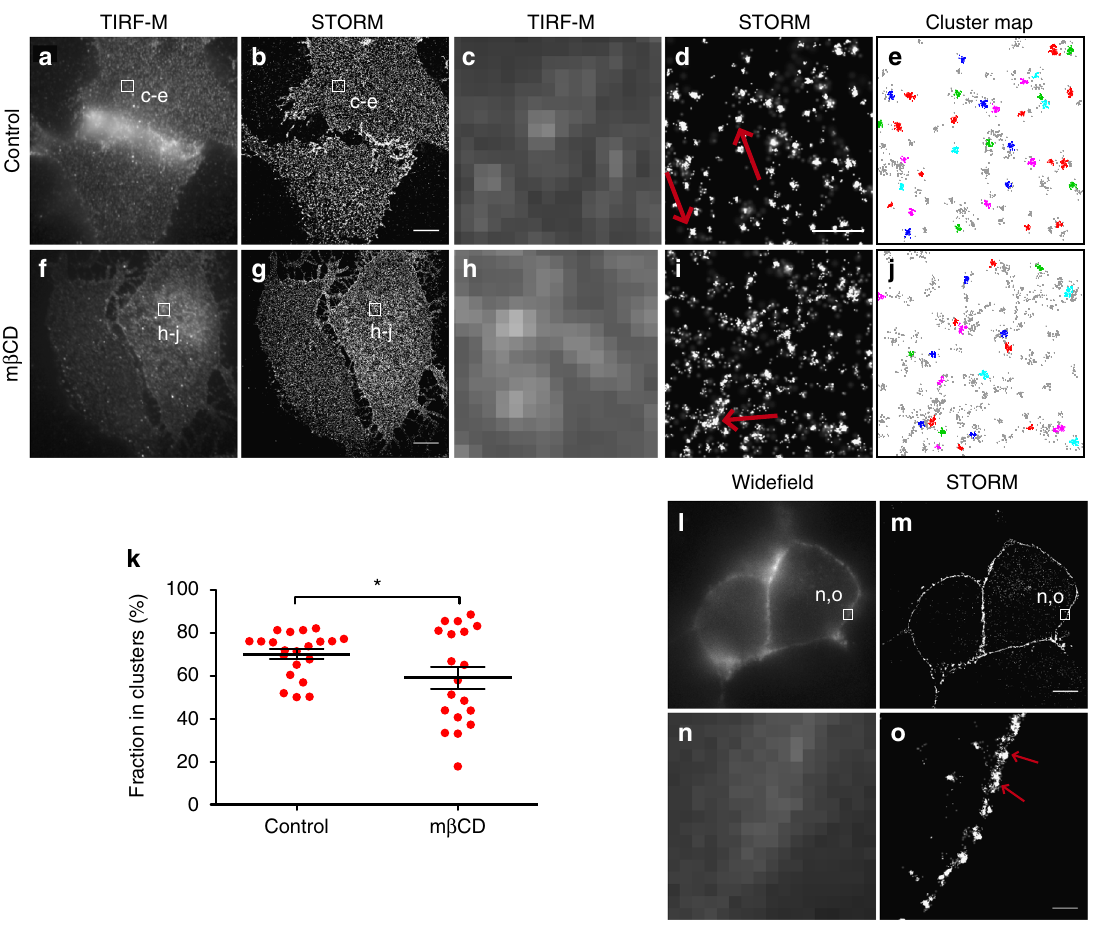
Fig. 2 Visualization of DAT by STORM in CAD cells. TIRF-M ( a , c , f , h ), STORM ( b , d , g , i , m , o ), and wide fi eld ( l , n ) images of CAD cells transiently expressing DAT with or without cholesterol depletion with 5 mM m β CD. DAT was visualized by immunolabeling with primary DAT antibody and Alexa405-Alexa647 conjugated-anti-rat secondary antibody. a , f TIRF-M view of DAT with (m β CD) or without cholesterol depletion (control). b , g Reconstructed STORM image of TIRF-M image in a or f . c , d , h , i Enlarged TIRF-M or STORM images corresponding to the boxed regions in a , b (control) or f , g (m β CD). e , j DBSCAN-based cluster map of the STORM images in d (control) and j (m β CD). Clustered localizations are shown by color-coding with non-clustered localizations in gray . k Fraction of particles (according to DBSCAN) clustered in nanodomains with (m β CD) or without cholesterol depletion (control). Data are % of localizations in cluster (means ± s.e.m., * p < 0.05, unpaired two-tailed t -test). l – o Visualization of DAT expressing CAD cells using inclined illumination to visualize a cross section through the cell. l Wide fi eld image, m reconstructed STORM image of wide fi eld image in l , n , o Enlarged TIRF-M or STORM images corresponding to the boxed regions in l , m . Red arrows mark DAT clustered in nanodomains. Data are based on 14 – 16 cells from three independent experiments. Scale bars a , b , f , g , l , m 5 μ m, c – e , h – j 500 nm, n , o